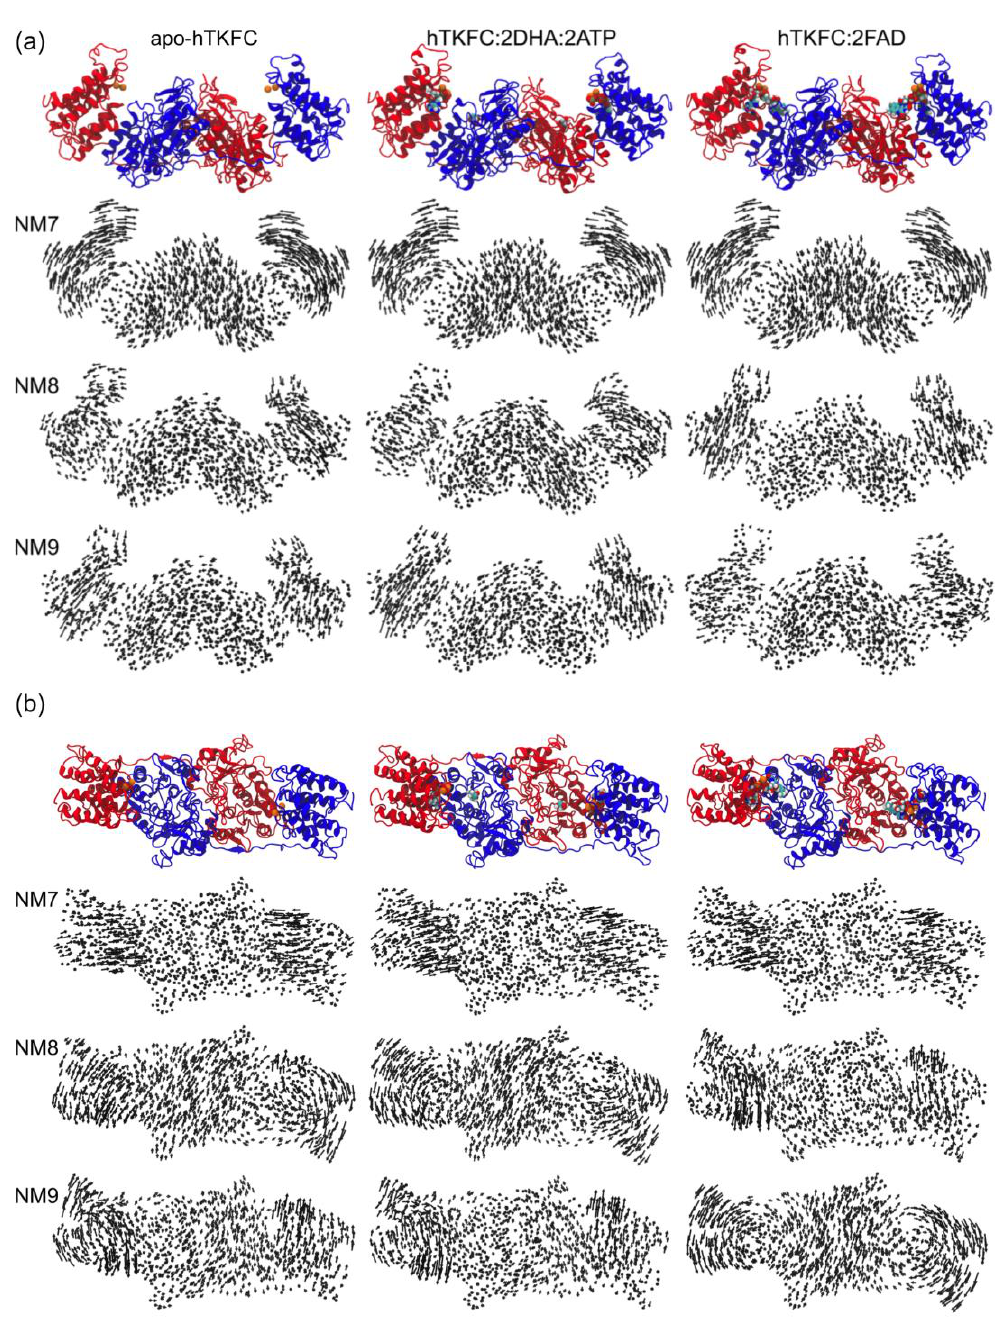
Figure 2. Porcupine representation of the first three non-trivial normal modes NM7–NM9 for the apo form of hTKFC and its complexes with kinase or FMN cyclase substrates. The arrows indicate the direction and extent of the motion for each C α atom. Other atoms were omitted for simplicity. ( a ) “Lateral” view, similar to Figure 1, ( b ) “top” view. The first line of each panel shows the energy-minimized structures used for the normal mode analysis. An animated representation can be seen in Supplemental movie 1. The correspondence with the three universal modes of bilobate structures is indicated in Figure 3.